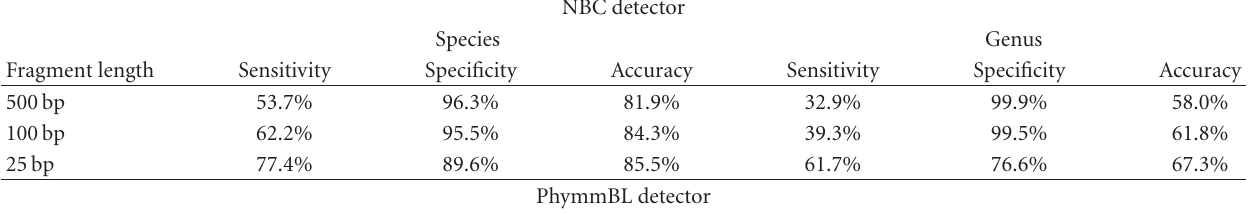
Table 1: Sensitivity, specificity, and (detector) accuracy rates of detectors for accepting/rejecting reads as “known” from a 275-strain test-set. Using 5-fold cross-validation, the maximum standard deviation is 1%. If all fragments were rejected, the species level would obtain 66% accuracy and the genus level 37% accuracy, and PhymmBL+Detector achieves 15–30% above this threshold. SOrt-ITEMS did not classify any fragment below the genus level, so N/A is designated for the species level. WebCarma’s performance using 500 bp fragments resulted in a 20.1% sensitivity, 86.9% specificity, and 54% detector accuracy for the species level, and 23% sensitivity, 85% specificity, and 40.3% detector accuracy for the genus level. WebCarma only classified about 10K of the 27.5 K reads. Due to its poor performance, we did not include it